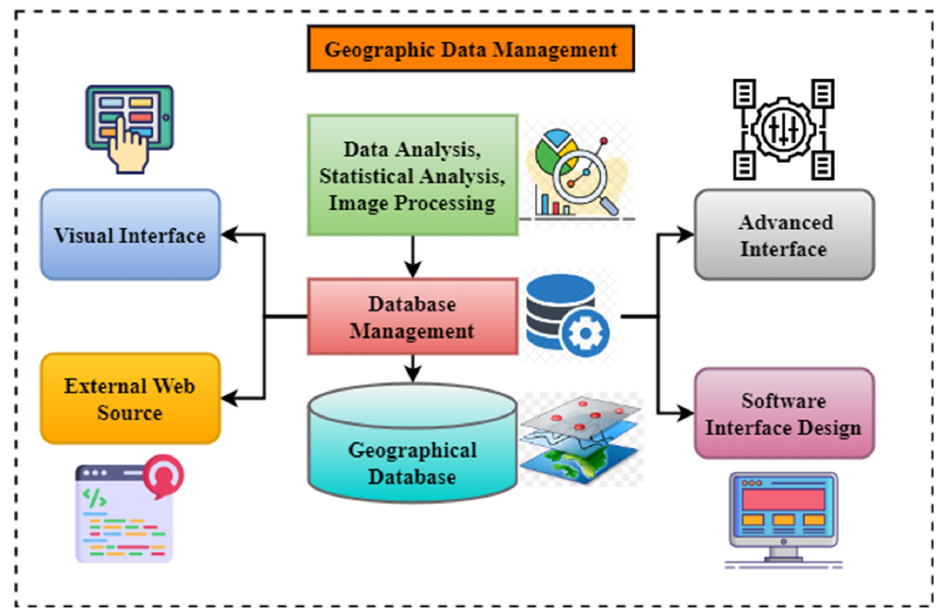
Figure 2. Geographic data management.